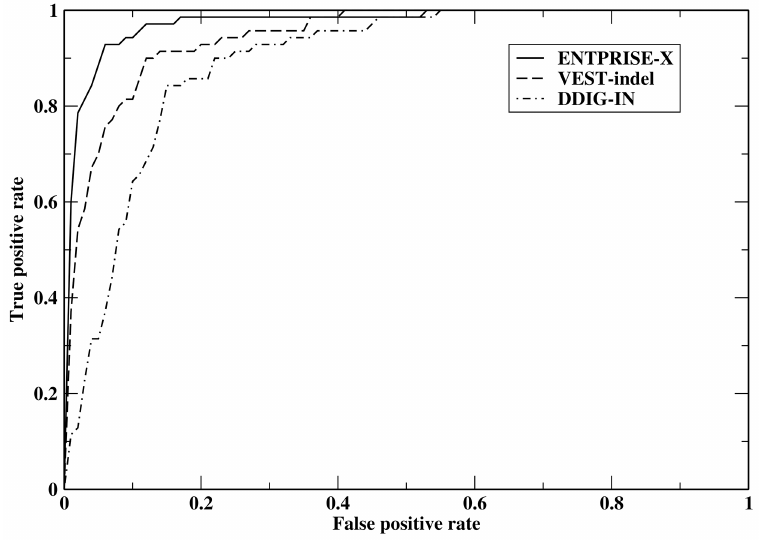
Fig 1. Receiver operating characteristic curves of ENTPRISE-X, VEST-indel and DDIG-in.